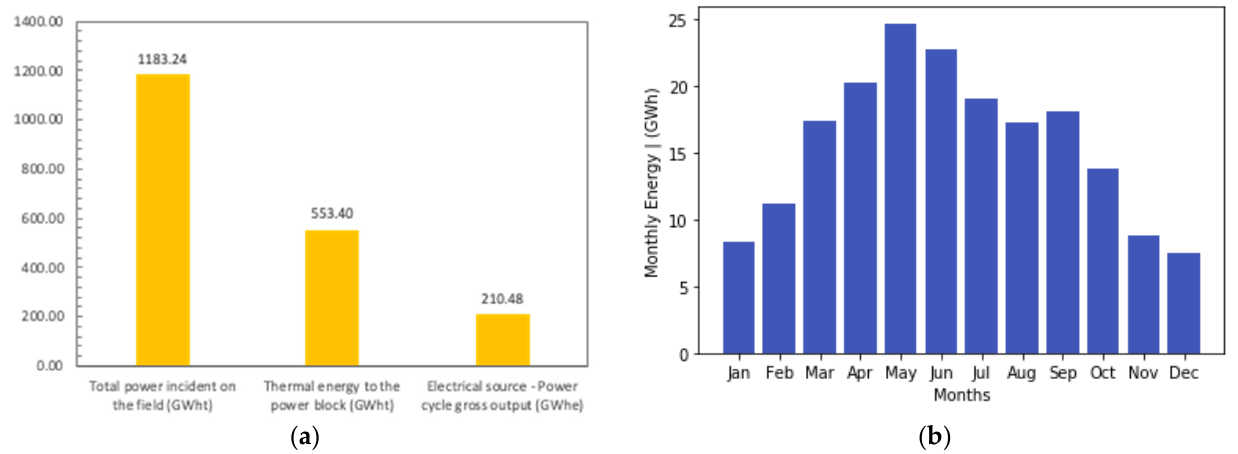
Figure 9. ( a ) Annual performance chart and ( b ) monthly electrical power generated from the opti- mized PTC plant . Table 5. Simulation results for the optimized 50 MWe PTC plant .